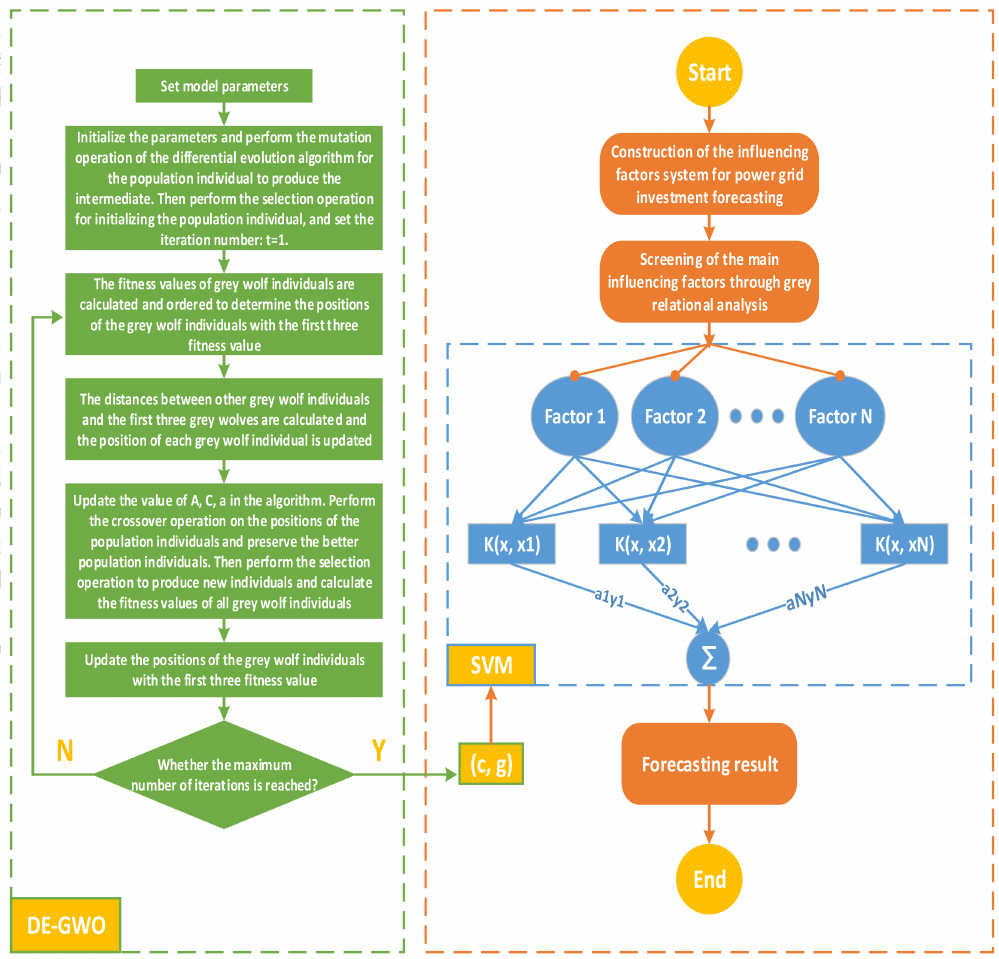
Figure 3. The flow chart of